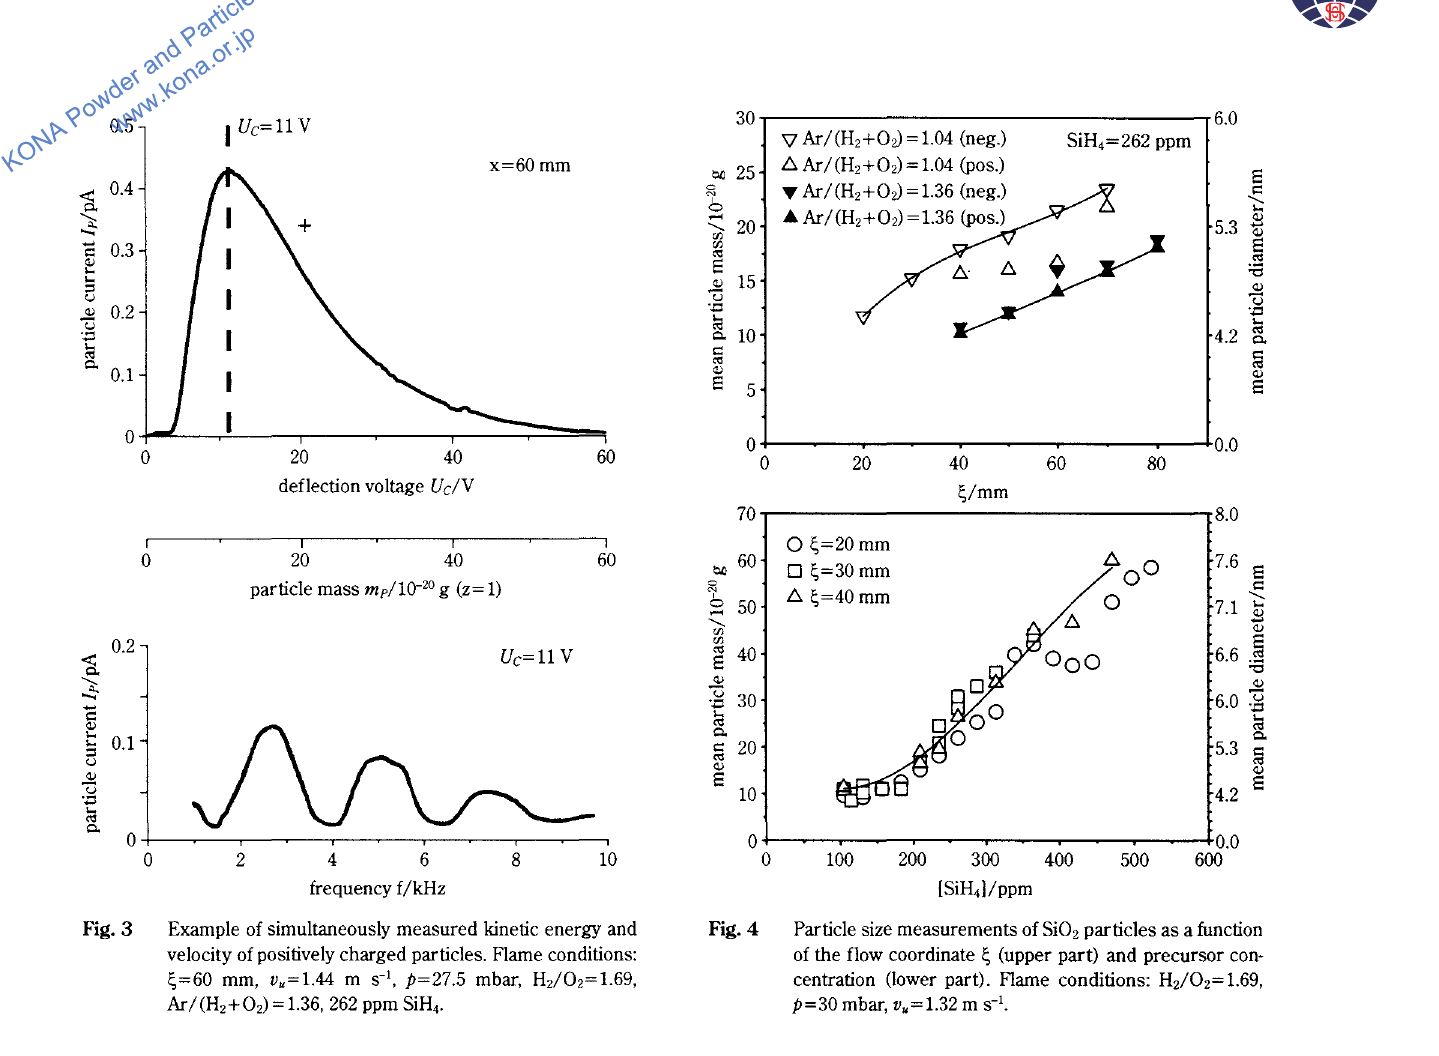
Fig. 3 Example of simultaneously measured kinetic energy and velocity of positively charged particles. Flame conditions: ~=60 mm, Vu=l.44 m s- 1, P=27.5 mbar, H 2 /0 2 =1.69, Ar I (H 2 + 0 2) = 1.36, 262 ppm SiH 4•